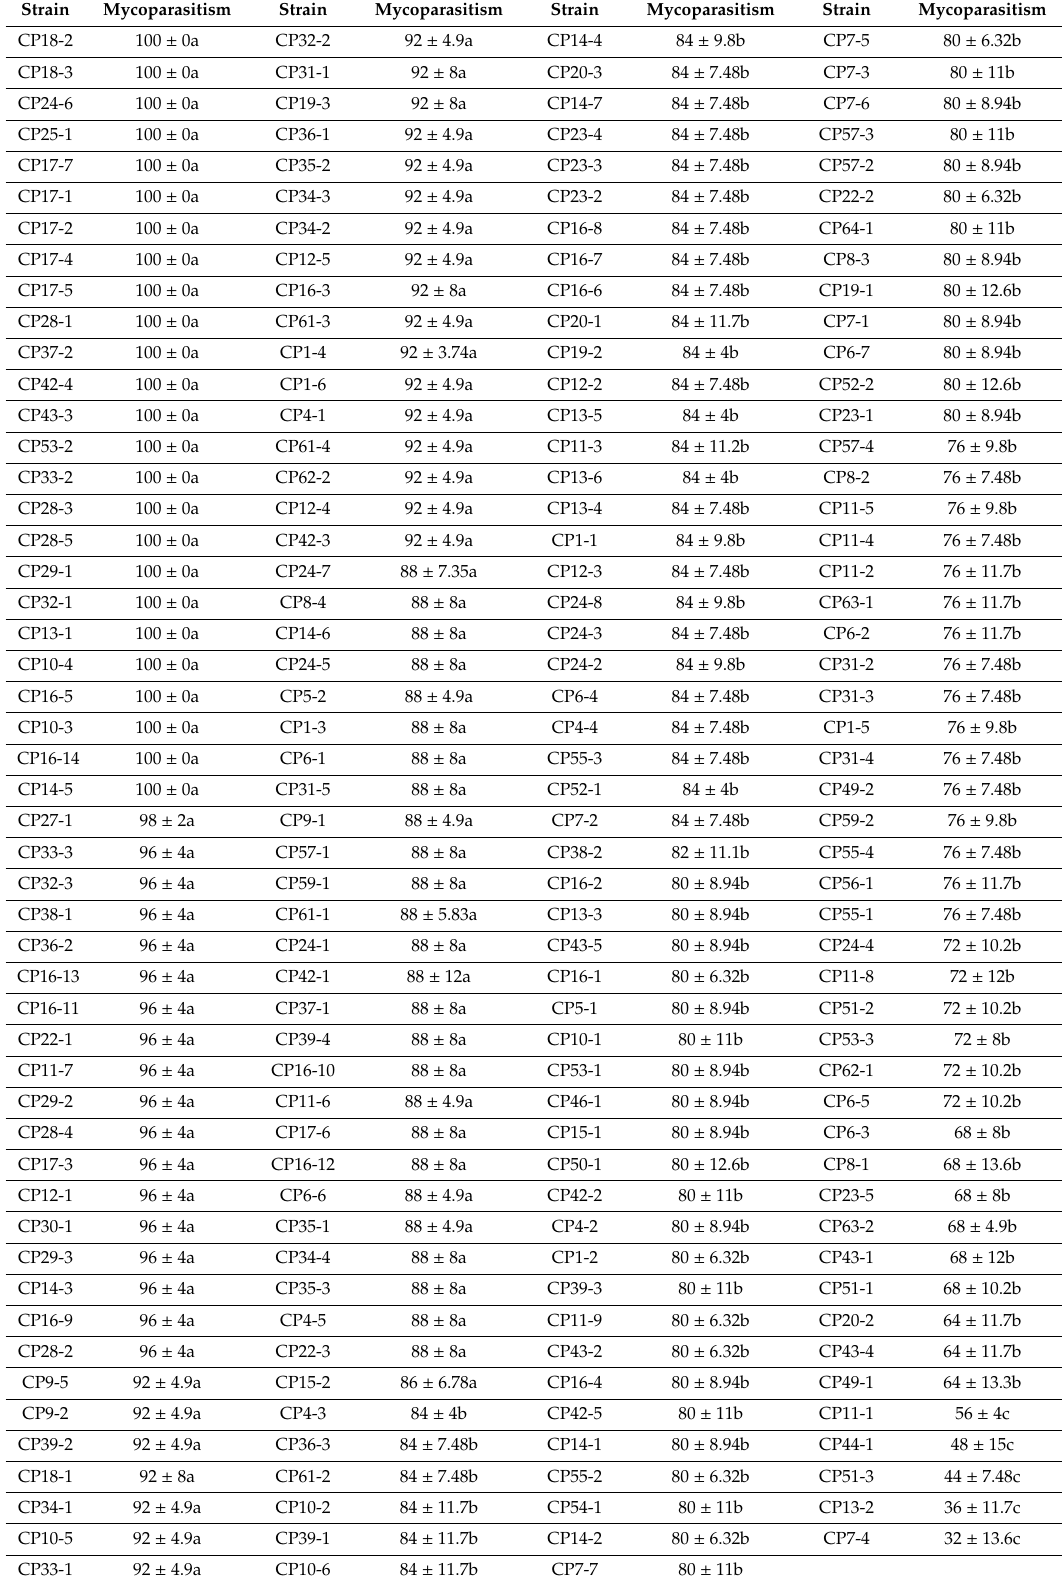
Table 2. Mycoparasitism of 199 native strains of Trichoderma from Bagua Province, Amazonas, Peru, evaluated over Moniliophthora roreri ( ± = standard error; average with the same letters are not statistically di ff erent (Scott Knott, α =